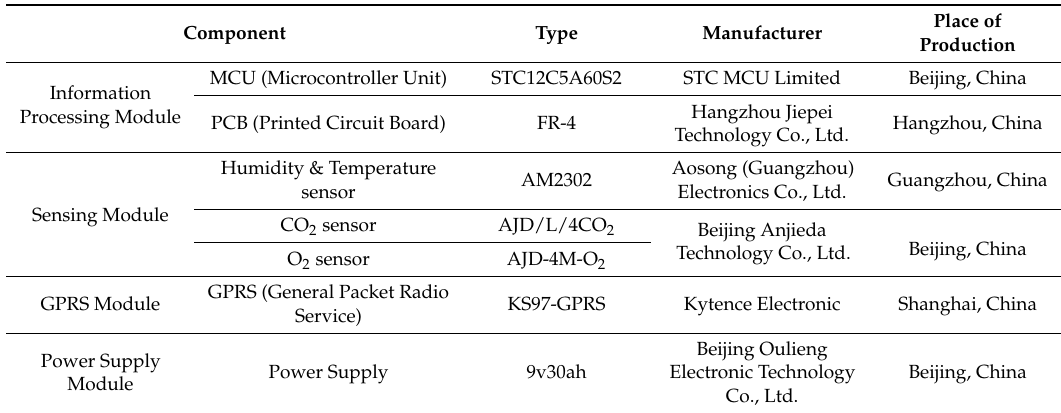
Table 2. Instructions of